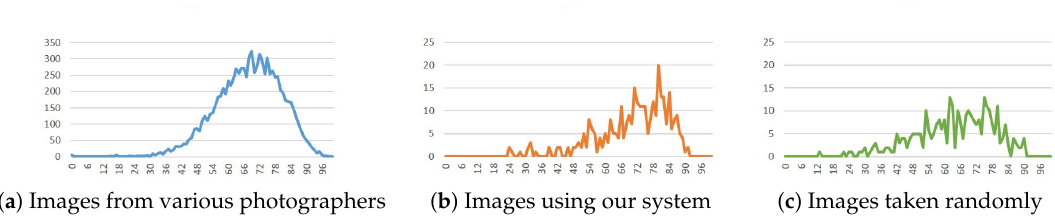
Figure 44. Results for the focus composition method.